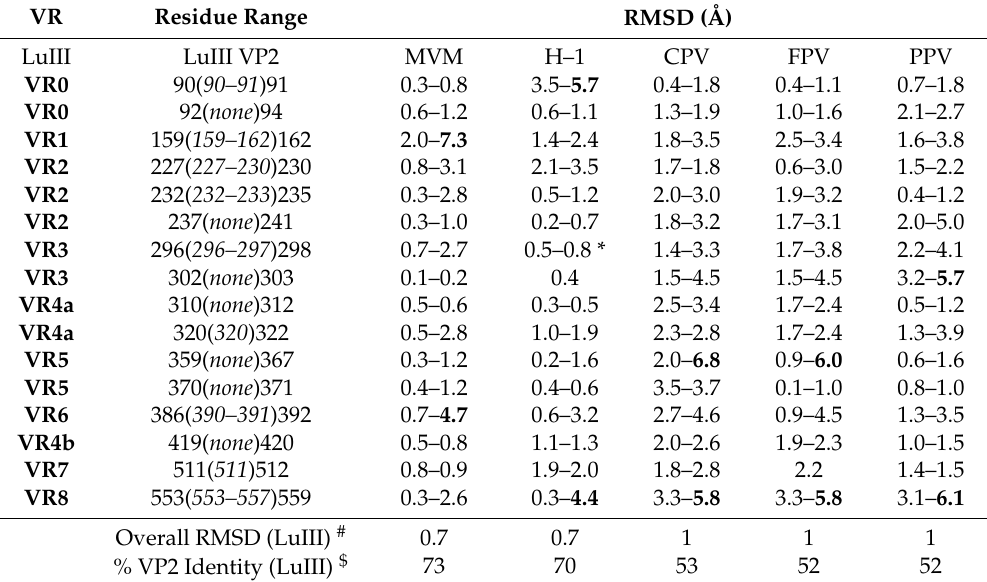
Table 3. Superposition Comparison of LuIII to other